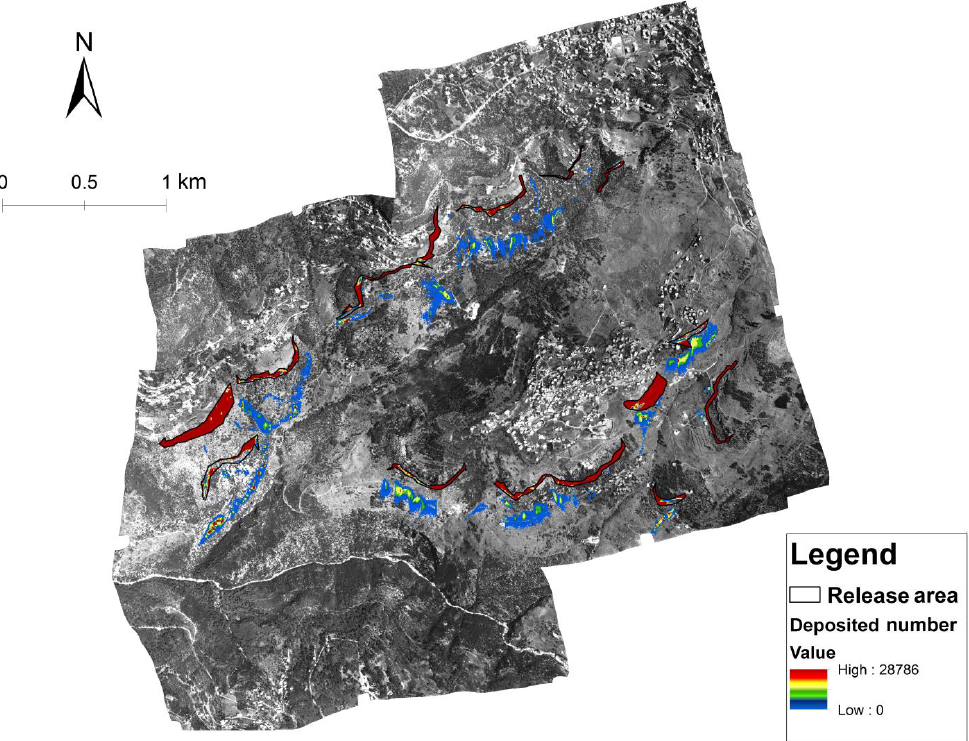
Figure 11. The obtained deposited number of rocks after 1000 simulations for the case scenario: wet condition.